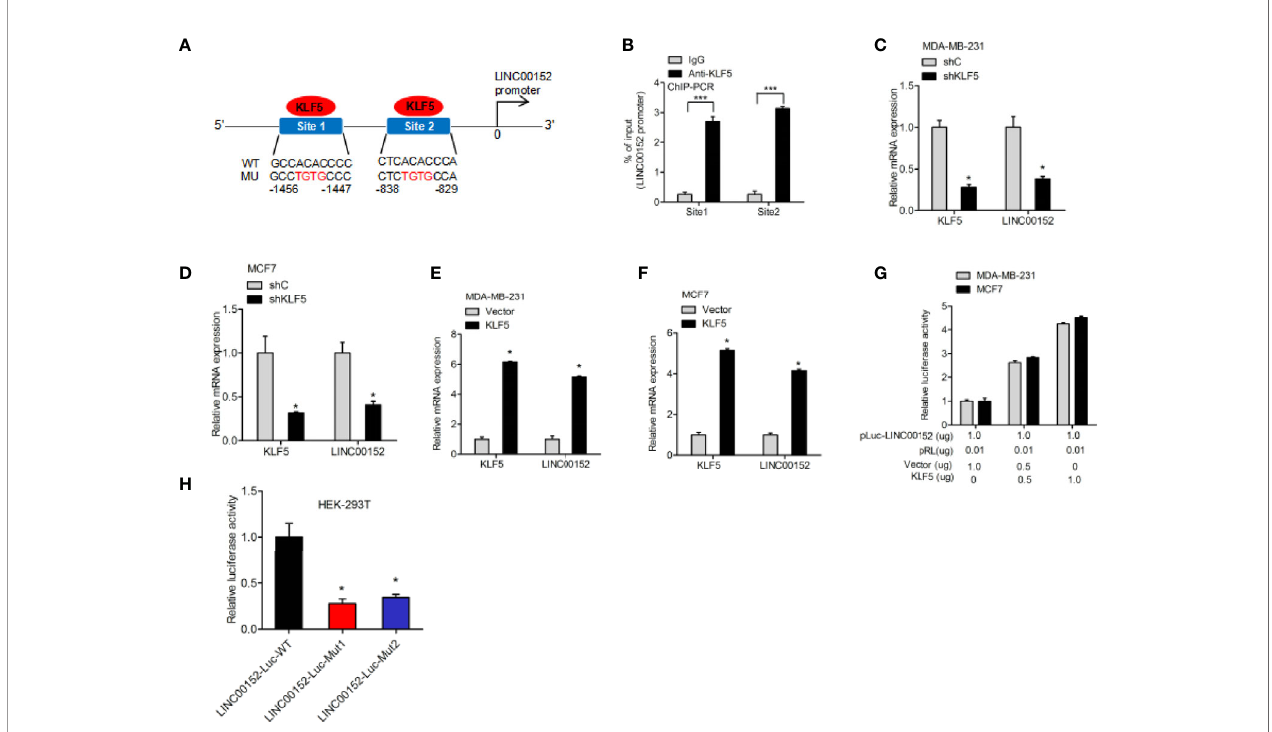
FIGURE 5 | >KLF5 regulates LINC00152 expression through LINC00152 promoter binding. (A) Schematic diagram of putative KLF5-binding sites in LINC00152 promoter. (B) ChIP-qPCR assay of KLF5 binding to LINC00152 promoter. (C, D) qRT-PCR analysis of effect of KLF5 depletion on LINC00152 expression in MDA- MB-231 and MCF7 cells. (E, F) qRT-PCR analysis of effect of KLF5 overexpression on LINC00152 expression in MDA-MB-231 and MCF7 cells. (G) Luciferase assay of KLF5 regulation on the LINC00152 promoter activity in MDA-MB-231 and MCF7 cells. (H) Luciferase assay of KLF5 site regulation on the LINC00152 promoter activity in HEK-293T cells. *P < 0.05. ***P < 0.001. Error bars represent SD. Data are representative of three independent